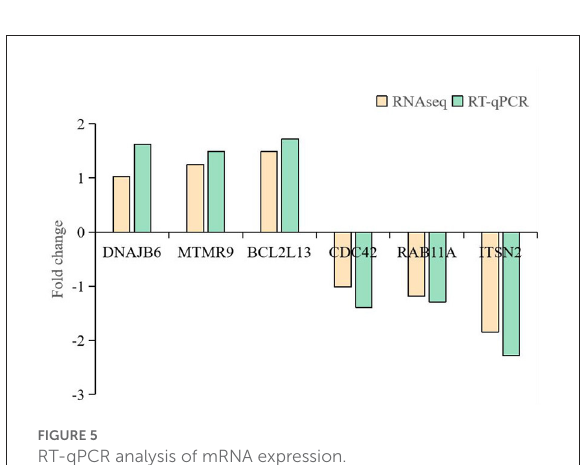
enriched source genes of DE circRNAs were visualized by using Cytoscape. As shown in Figure 3C, the result showed that six source genes ( CDC42 , BRAF , PPP3CB , RAB11FIP2 , RAB11A , and TSC2 ) were detected to be enriched in the significantly changed immune related